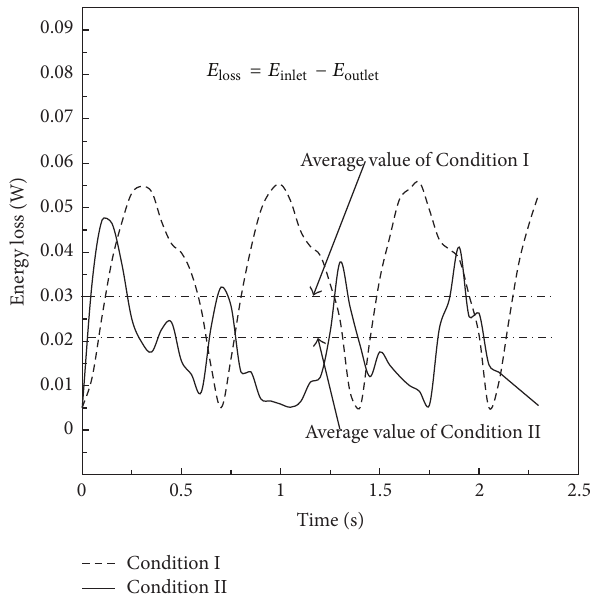
Figure 10: Results of energy loss at Condition I and Condition II.